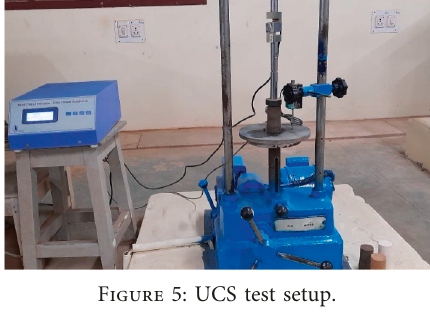
Figure 5: UCS test setup.